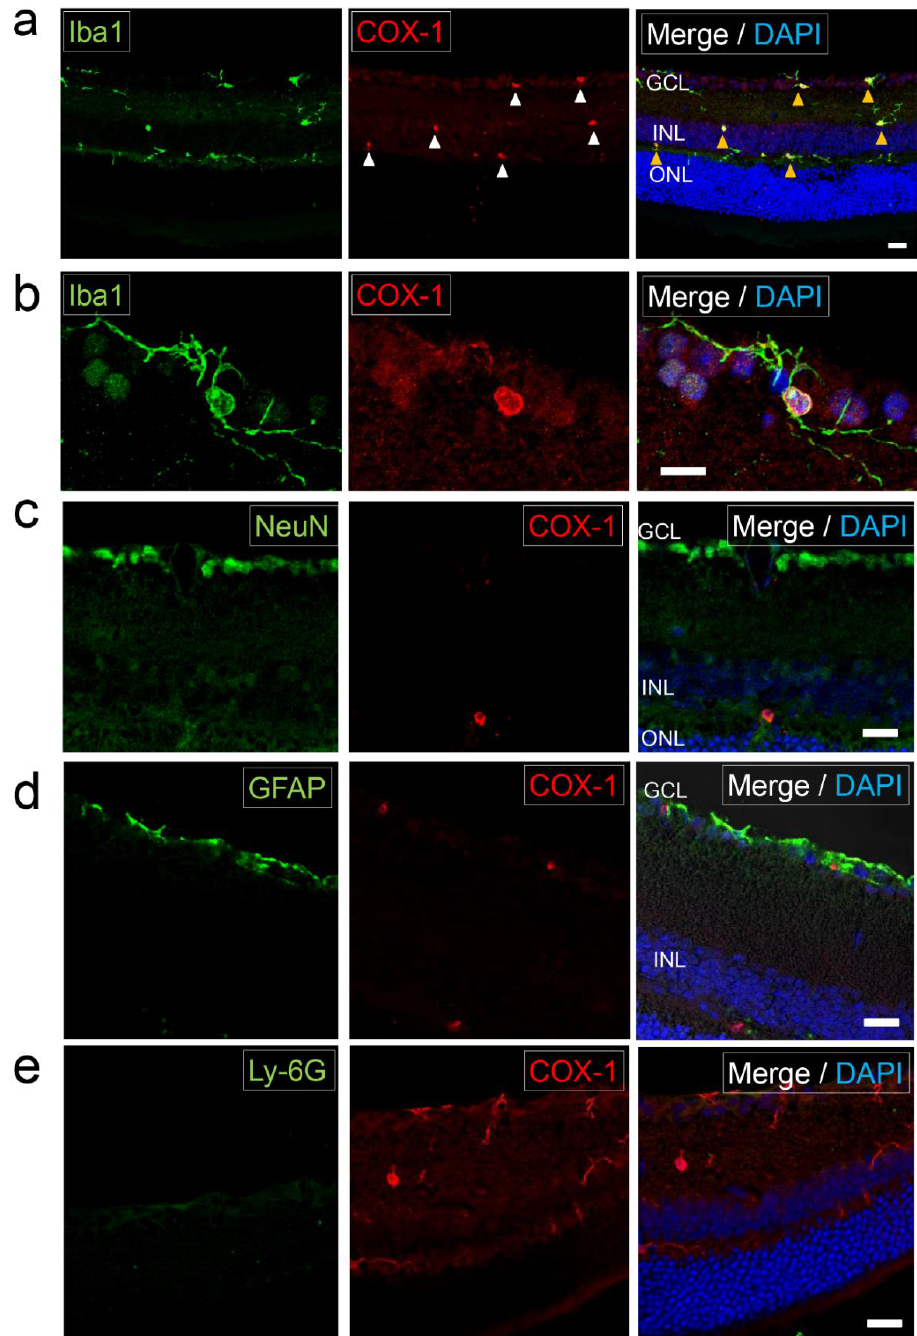
Figure 1. Expression of cyclooxygenase-1 (COX-1) in normal retina Photomicrographs of the retina in normal C57BL/6J mice. ( a ) The retinal section labeled with Iba1 (microglia/macrophage marker) and COX-1. There were COX-1 + cells in the GCL, IPL, INL, and OPL (white arrowheads). The COX-1 staining coincided with Iba1 + microglia (yellow arrowhead) that had ramified (resting state) morphology. Scale bar, 20 μm. ( b ) Photomicrographs showing a magnified image of microglia in the retina that had ramified morphology with long processes. Microglia with long processes were positive for Iba1 and COX-1. Scale bar, 10 μm. ( c ) The retinal section labeled with NeuN (neuronal marker) and COX-1. COX-1 staining did not coincide with NeuN + cells. Scale bar, 20 μm. ( d ) The retinal section labeled with GFAP (astrocyte/Müller cell marker) and COX-1. COX-1 staining did not coincide with GFAP staining. Scale bar, 20 μm. ( e ) Retinal section labeled with Ly-6G (neutrophil marker) and COX-1. There were no Ly-6G + cells in normal retina. Scale bar, 20 μm.